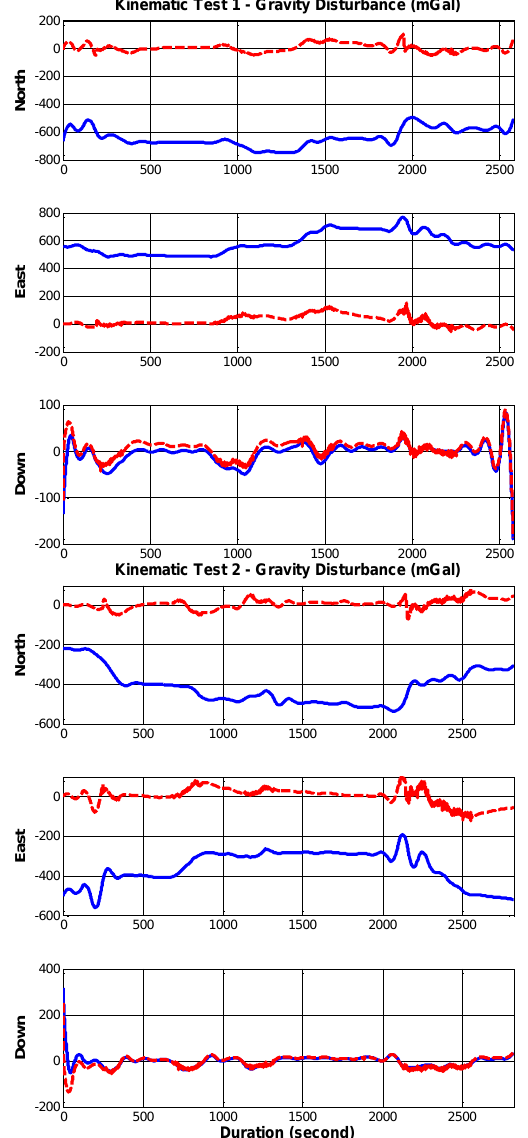
Figure 6. Vector gravimetry determined by using Kalman filter Figure 5. The accelerations (m/s 2 ) derived from INS (blue) and (red) and derived from direct subtraction (blue) GNSS (red) in n-frame As an indication of internal accuracy, the results of vector gravimetry estimated from the Kalman filter at crossover points are analyzed. The analysis used 38 crossover points (the distance of two points from two tests is less than 30 cm). Table 3 shows the means and standard deviations (STDs) of the differences in the gravity disturbance vector at crossover points after the outliers have been removed to avoid the errors from the dynamic motion and environment. As expected, the internal accuracy in the down component is higher than that in the horizontal components because the orientation errors could cause large error in the horizontal components.